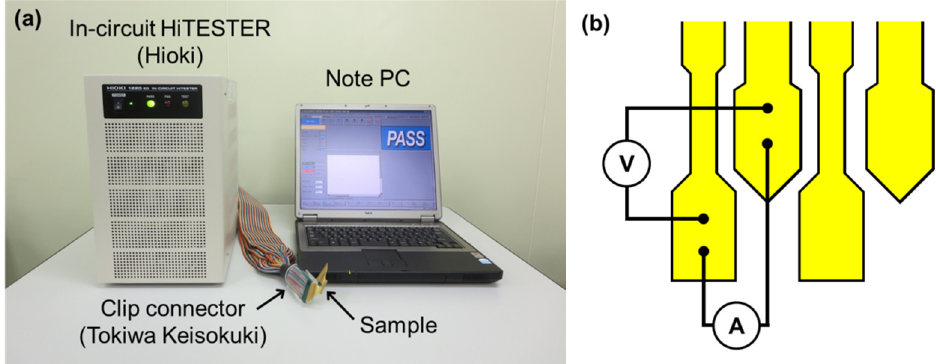
Figure 4. Measuring system: ( a ) photograph of the system and ( b ) schematic of the four-point probe